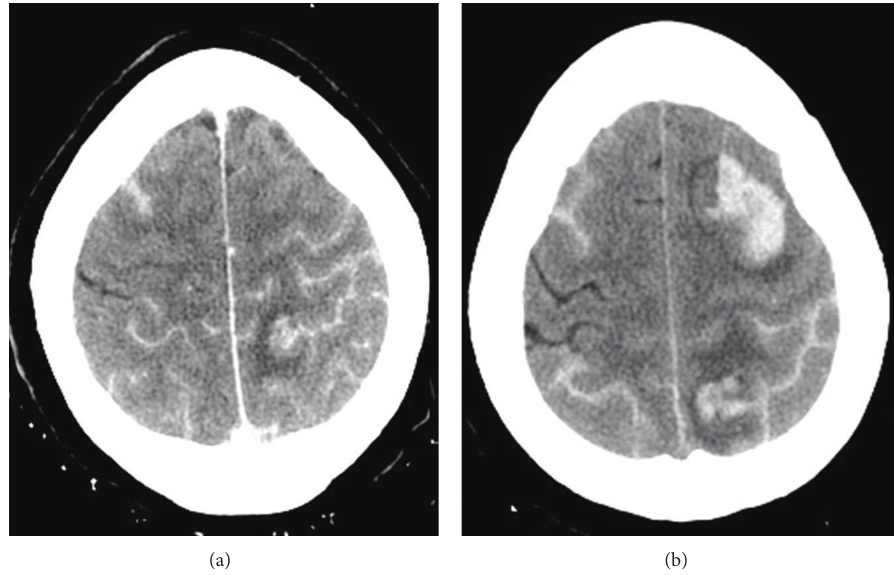
Figure 5: Initial cranial CT demonstrated convexity subarachnoid hemorrhage and a 1.5cm left superior parietal acute intraparenchymal hemorrhage (a). Three days later, the patient developed acute right hemiplegia. Repeat CT demonstrating a new 3.3 × 1.7cm left frontal intraparenchymal hemorrhage